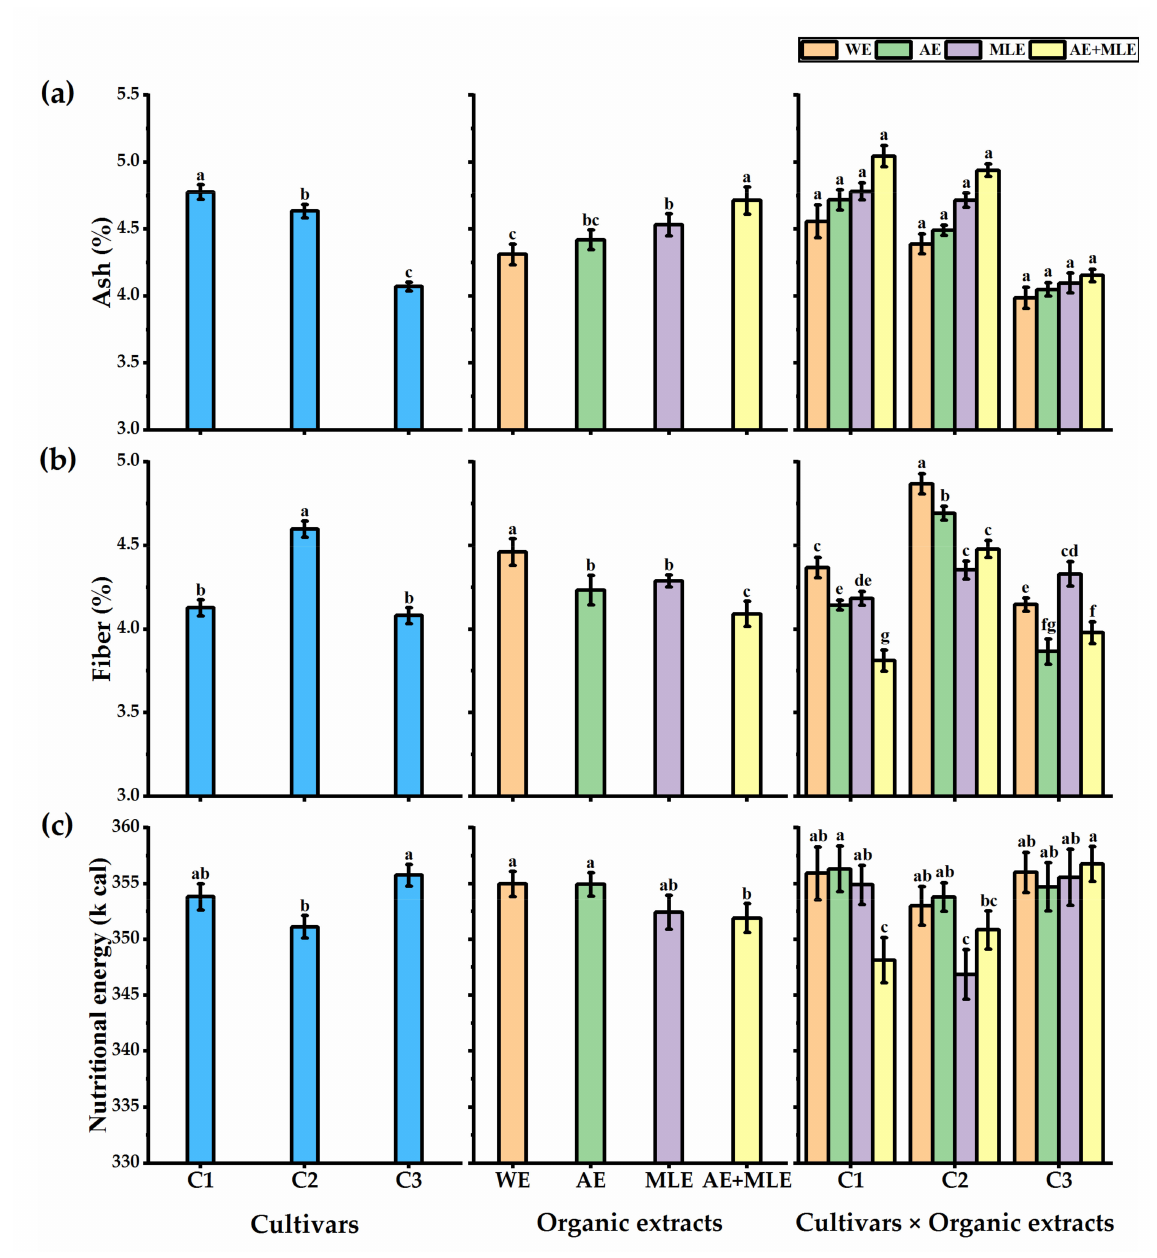
Figure 5. Effect of Azolla extract, moringa leaf extract, and their combination on ( a ) ash (%), ( b ) fiber (%), and ( c ) nutritional energy (kcal) of three quinoa cultivars. C1 = KVL − SRAZ, C2 = Chipaya, C3 = Q − 37, WE = without extract, AE = Azolla extract, MLE = moringa leaf extract. Data are mean value ± SE, n = 3. Different letters denote significant differences at p ≤ 0.05